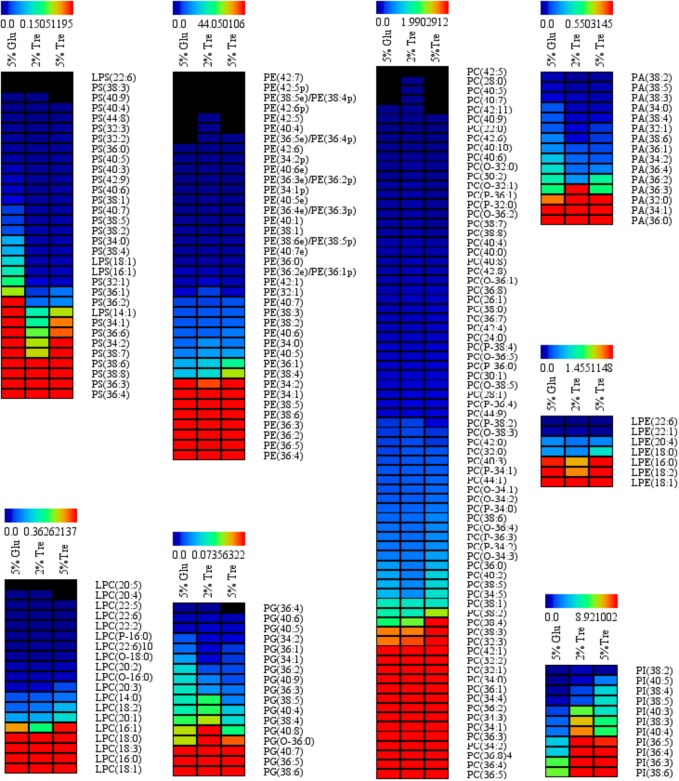
Phospholipid (PL) abundance in C. echinulata FR3 using 5% glucose, 2% trehalose, and 5% trehalose as carbon sources.